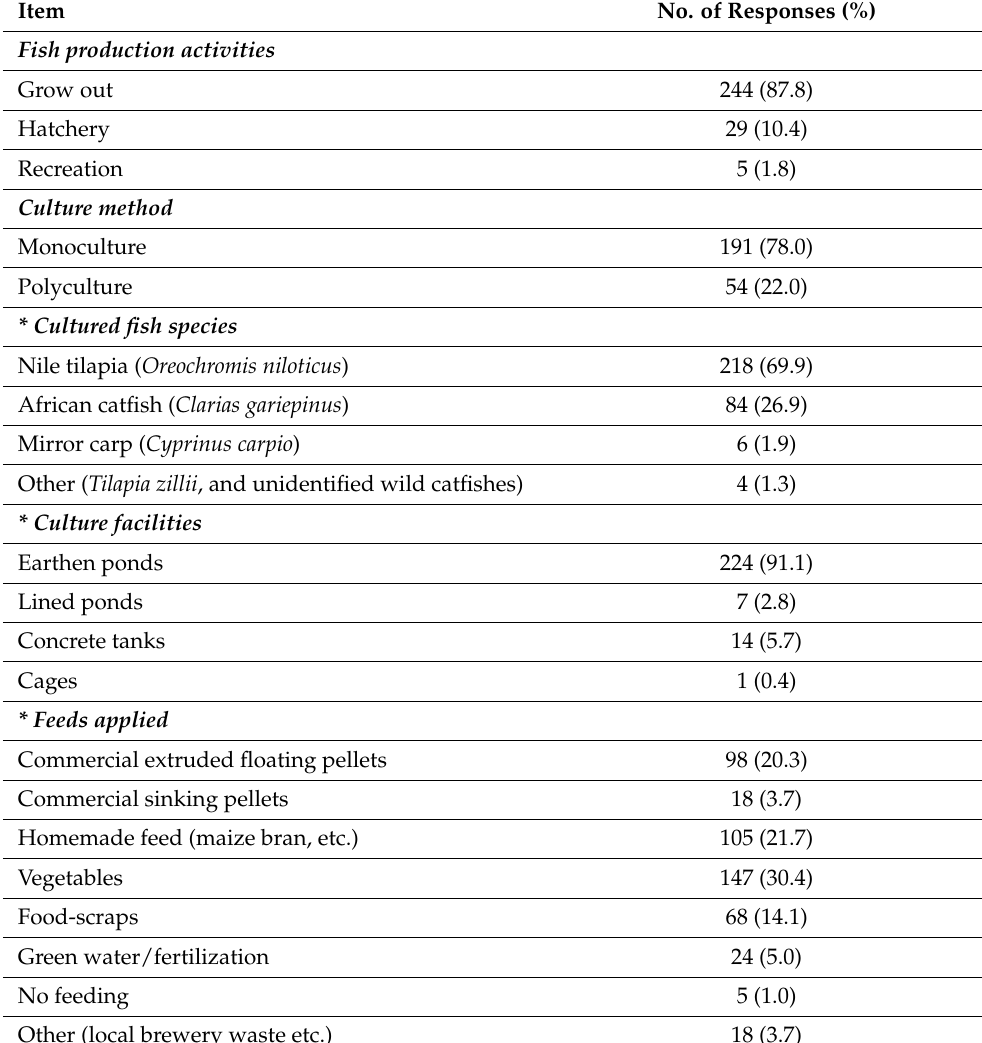
Table 2. Fish production characteristics of selected fish farms in districts of the Rwenzori